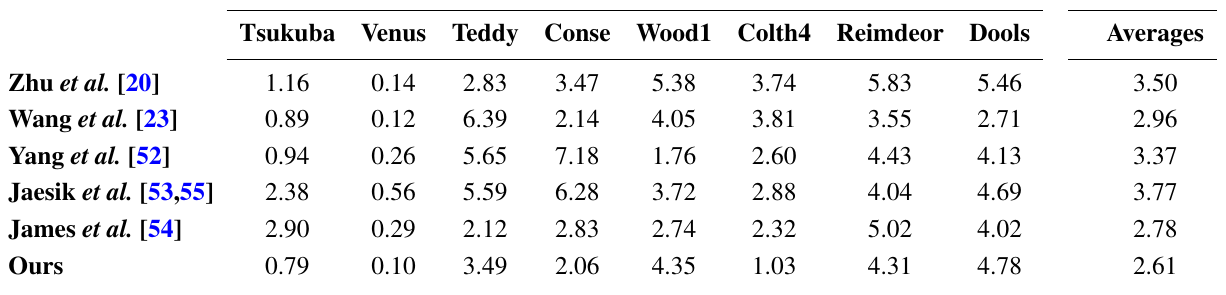
Table 3. The percentages of error pixels (absolute disparity error larger than 1 in non-occlusion regions) of our method and other “fused” methods on the Middlebury datasets. “Averages” are the average percentages of error pixels over all images. Compared to the average error rate 3.27 % of the previous state-of-the-art “fused” methods, our method provides a lower average error rate of 2.61 % on the Middlebury datasets. It performs almost 20% better than other “fused” methods in the aspect of precision. The Percentages of Error Pixels (%) Tsukuba Venus Teddy Conse Wood1 Colth4 Reimdeor Dools Averages Zhu et al.